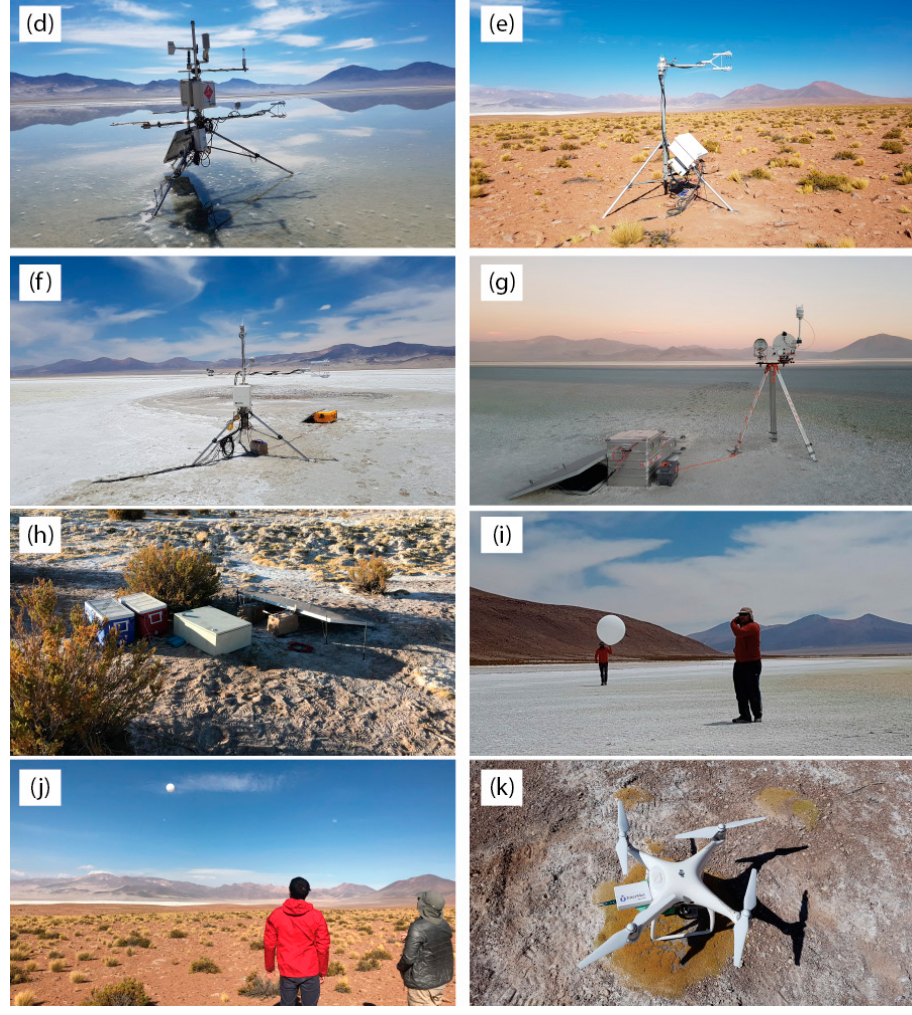
Figure 3. Photographs of the instrumentation used in the E-DATA field campaign: ( a ) Salar del Huasco lagoon during the morning; ( b ) meteorological station 1 of the EW transect (EW1); ( c ) meteorological station 1 of the NS transect (NS1); ( d ) EC-water; ( e ) EC-desert; ( f ) EC-wet-salt; ( g ) OMS Receptor; ( h ) DTS system in which the cool and ambient reservoirs are shown; ( i ) radiosonde preparation at the lagoon; ( j ) radiosonde launched at the desert location; and ( k ) UAV with the atmospheric sensor.